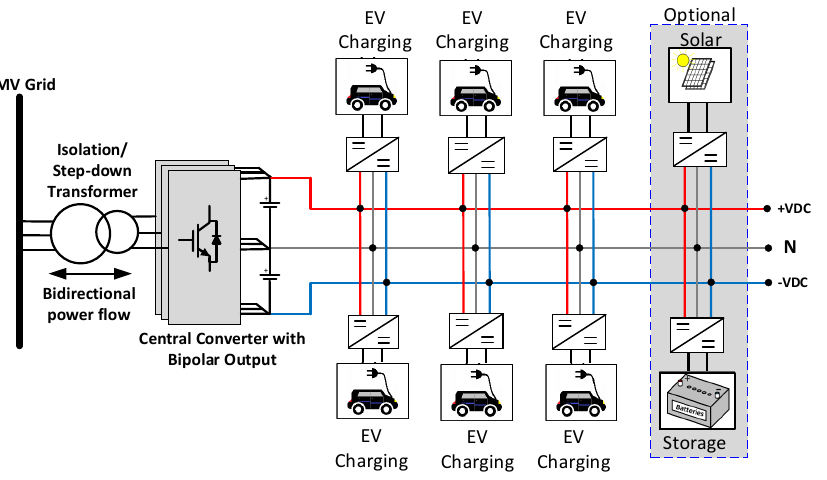
Figure 9. One of the perspectives for a DC microgrid to be used in electric vehicles charging systems infrastructures.